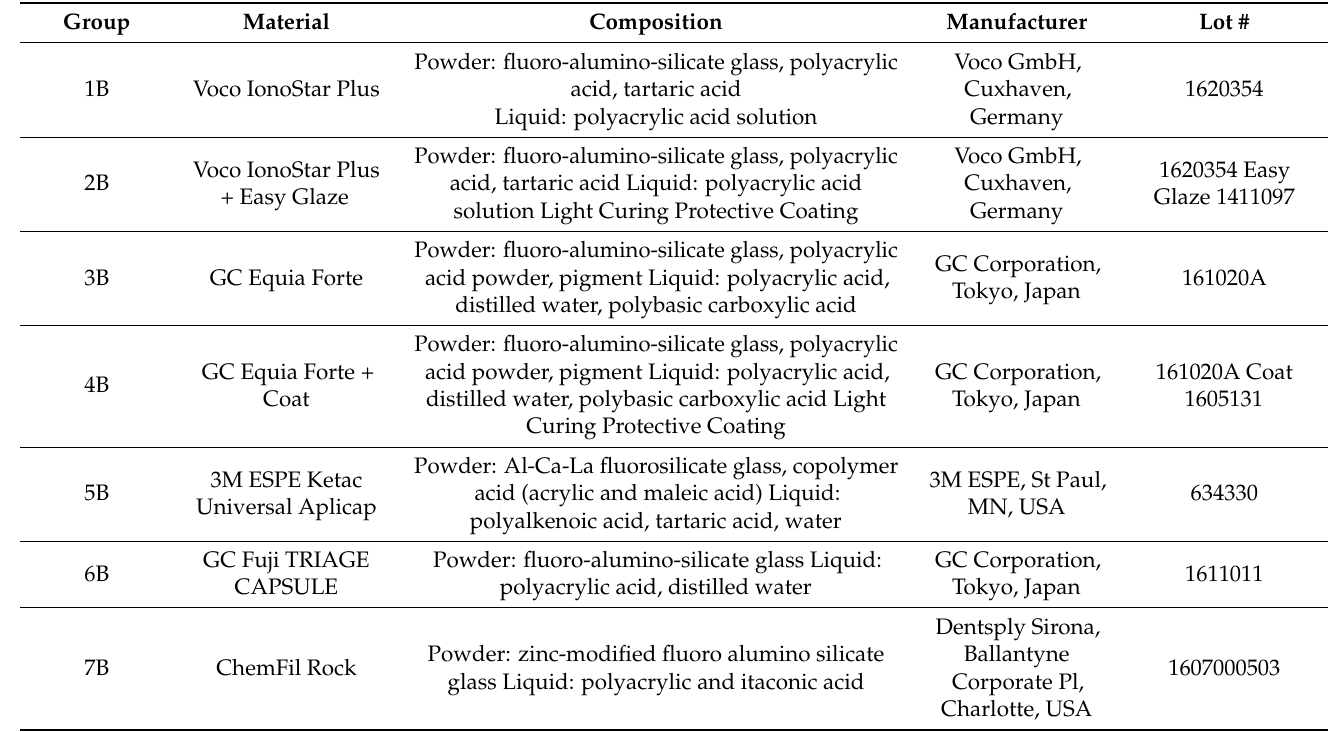
Table 2. Glass-ionomers tested in this